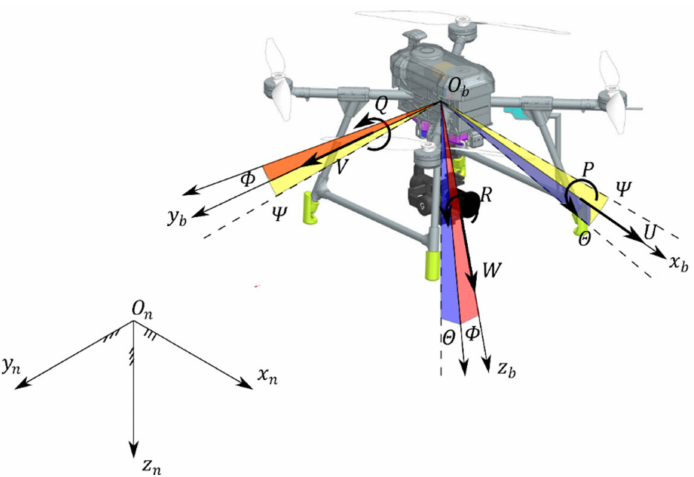
Figure 3. Coordinate systems